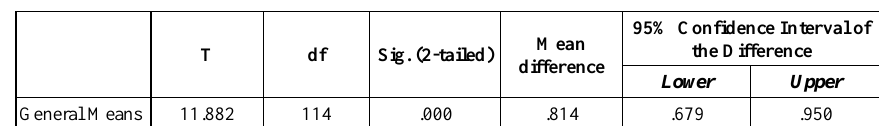
Table 4. One-sample t-test of general means (Test value =